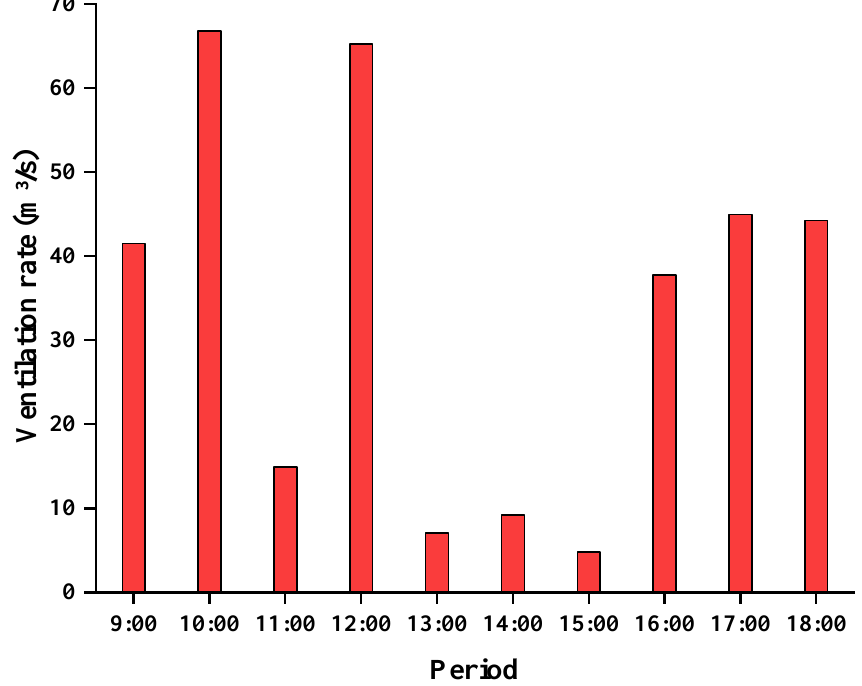
Figure 17. Sample values of greenhouse ventilation rate.